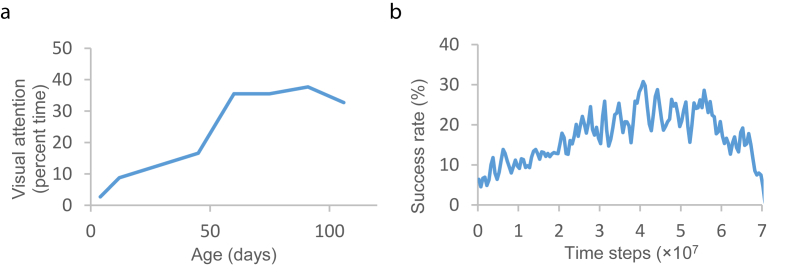
Visual attention and success rate: (a) Development of visual attention for the subjects assigned to the control group. Each point represents “the average of two scores taken during successive two-week periods” (White and Held, 1966). (b) Plot of an ensemble average of success rates, obtained by training ten times.